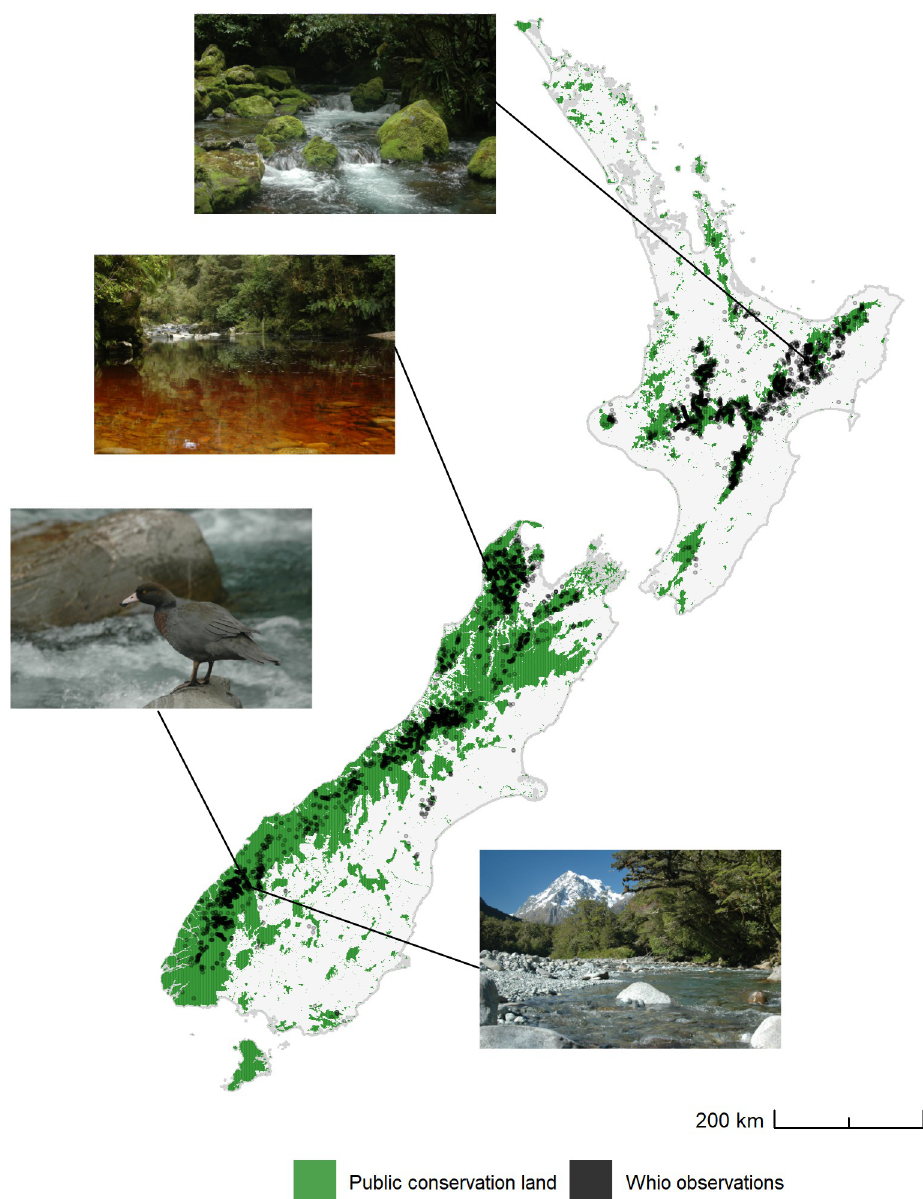
Fig 1. Distribution of whio observations in New Zealand from 1979–2016 relative to public conservation land. Sites where contemporary populations of whio occur show a high diversity of habitats, suggesting their range is not restricted by a lack of suitable habitat. Photos top to bottom: Whirinaki, O¯p ā rara, Cleddau, and Clinton Rivers [Photo credit–ALW]. Public conservation land republished from https://koordinates.com/layer/754/ under a CC BY license, with permission from Department of Conservation, original copyright